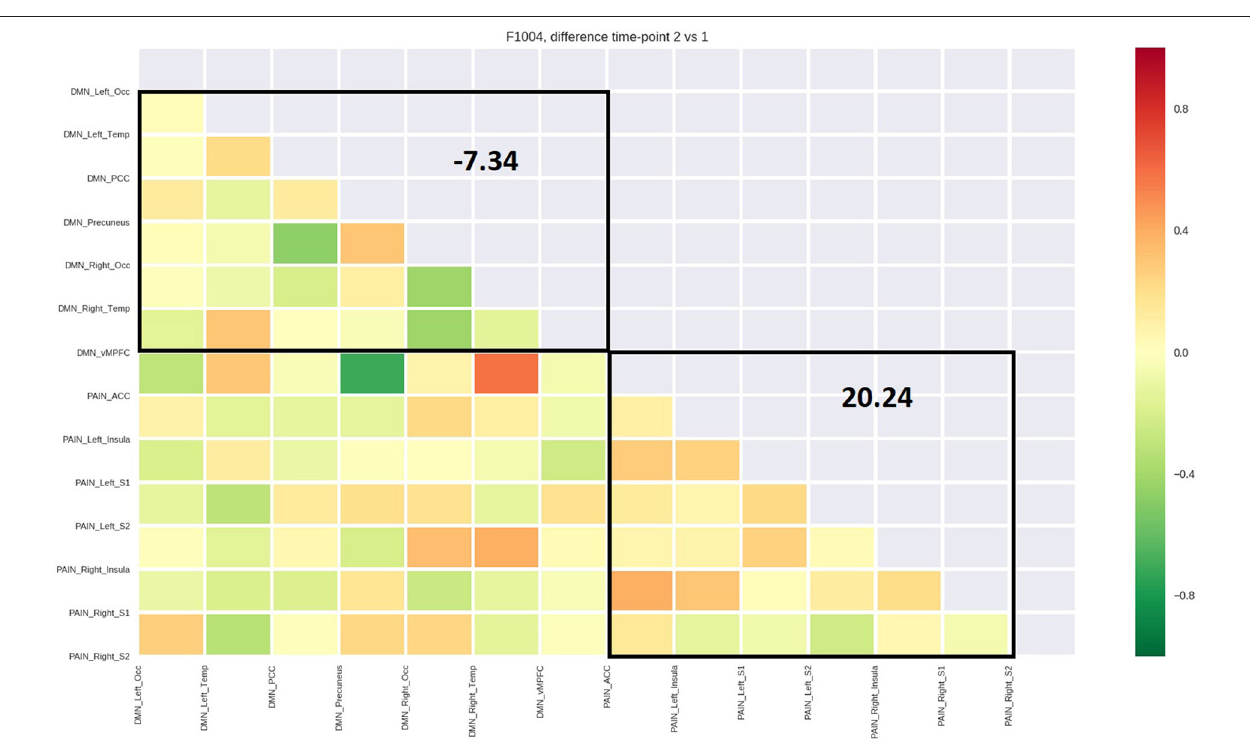
Frontiers in Neurology |